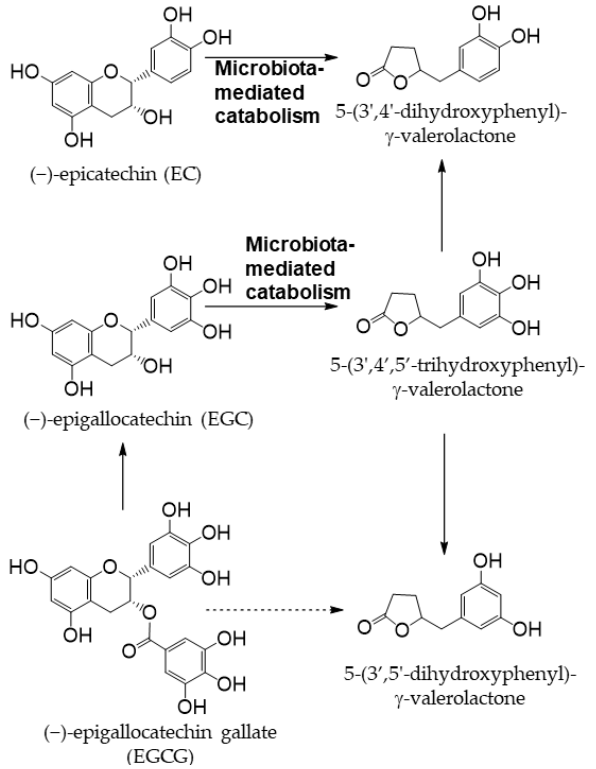
Figure 3. Schematic diagram of the biotransformation of main tea catechins. Modified from [35].